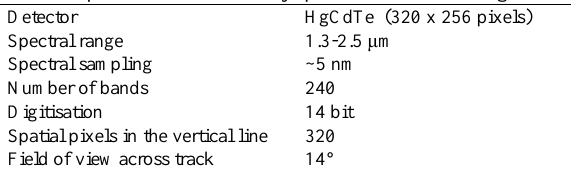
Table 1. Specifications of the HySpex SWIR-320m imager